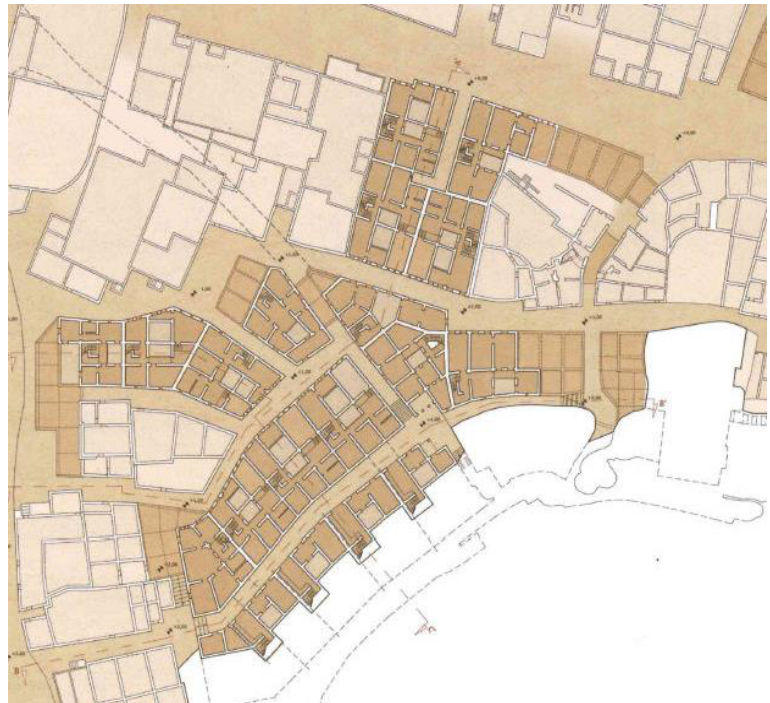
Figure 9. Example of the “mending” urban project within the Siwa Oasis (drawings courtesy of the following authors: Calvano S., Loconte P., Pizzolante S., Ricupero P. and Vitulli